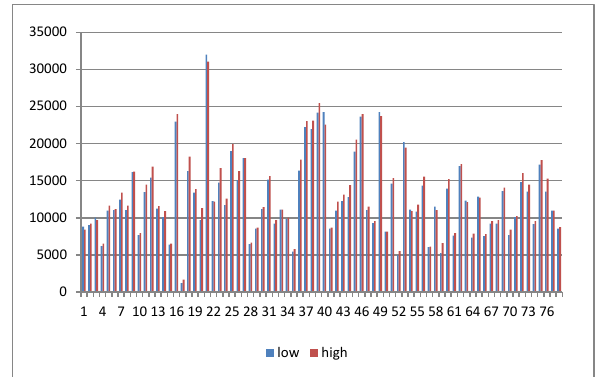
Figure 14 Comparison of sky patch resolution and its effect (radiation in Wm -2 on the vertical axis)